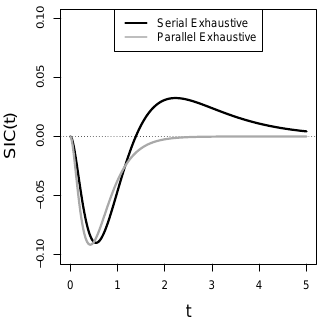
Figure 4. SIC ( t ) s simulated from a serial exhaustive system and a parallel exhaustive system with the same set of parameters for the density functions of the sub-channel processing